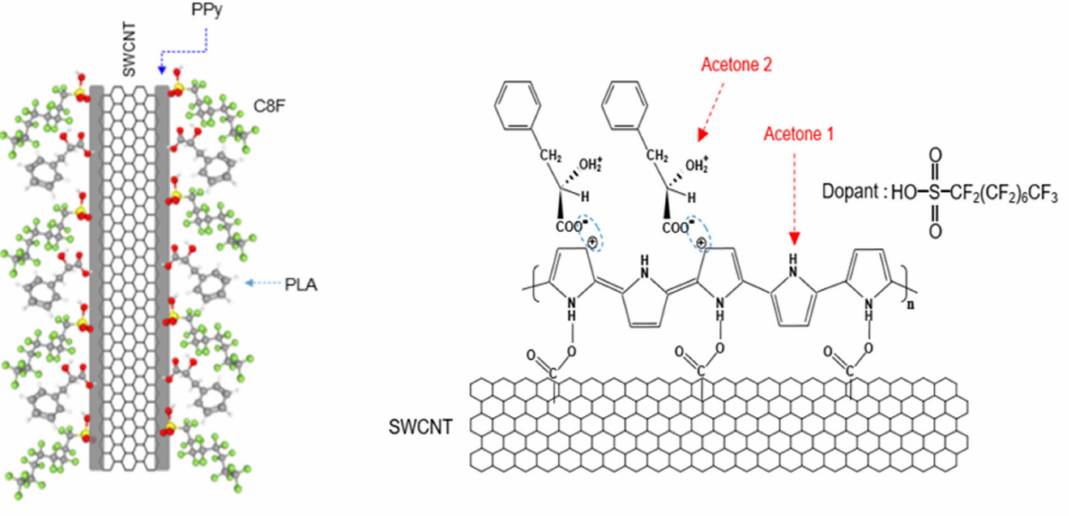
Figure 1. Schematic of and the chemical structure of C8F-doped-PPy/PLA@SWCNT core-shell- shaped nanocomposites for C 3 H 6 O gas